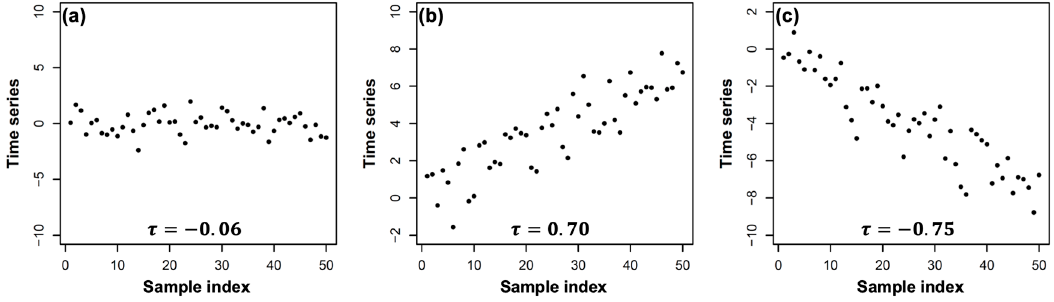
Figure 4. Three time series with di ff erent Kendall’s tau coe ffi cients: ( a ) τ = − 0.06; ( b ) τ = + 0.70; ( c ) τ = − 0.75 .